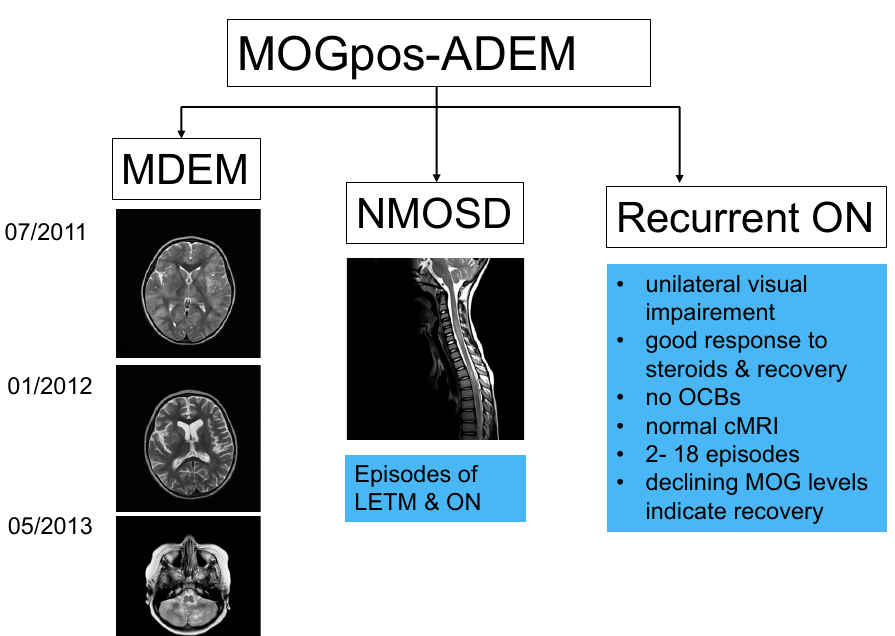
Figure 3. Children with acute disseminated encephalomyelitis (ADEM) and persistent myelin oligodendrocyte glycoprotein antibody (MOGpos-ADEM) are at risk of developing one of three recurrent demyelinating syndromes in addition to less well-characterized manifestations: multiphasic ADEM (MDEM), neuromyelitis optica spectrum disorder (NMOSD) generally with longitudinally extensive transverse myelitis (LETM) or recurrent optic neuritis (ON).